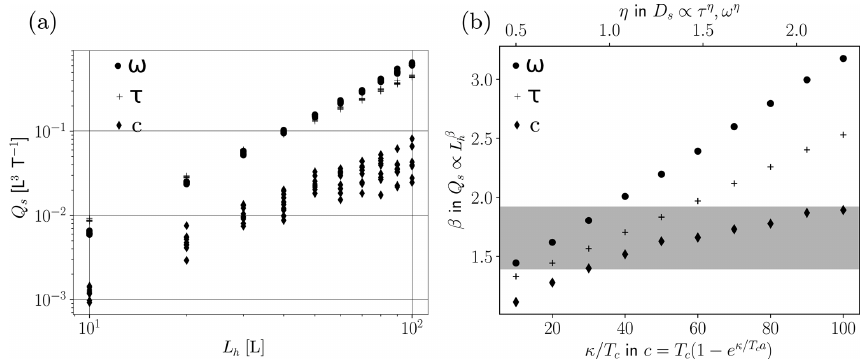
Figure 10. (a) Cumulative volume of detached sediment on hillslopes of length L h calculated by unit stream power, shear stress, and sediment concentration when w r = kQ 1 / 3 . (b) Best fit power law relationships for different sediment detachment rules (top axis) and rate constants, κ/T c , for sediment concentration. The range of observed nonlinear relationships is highlighted in